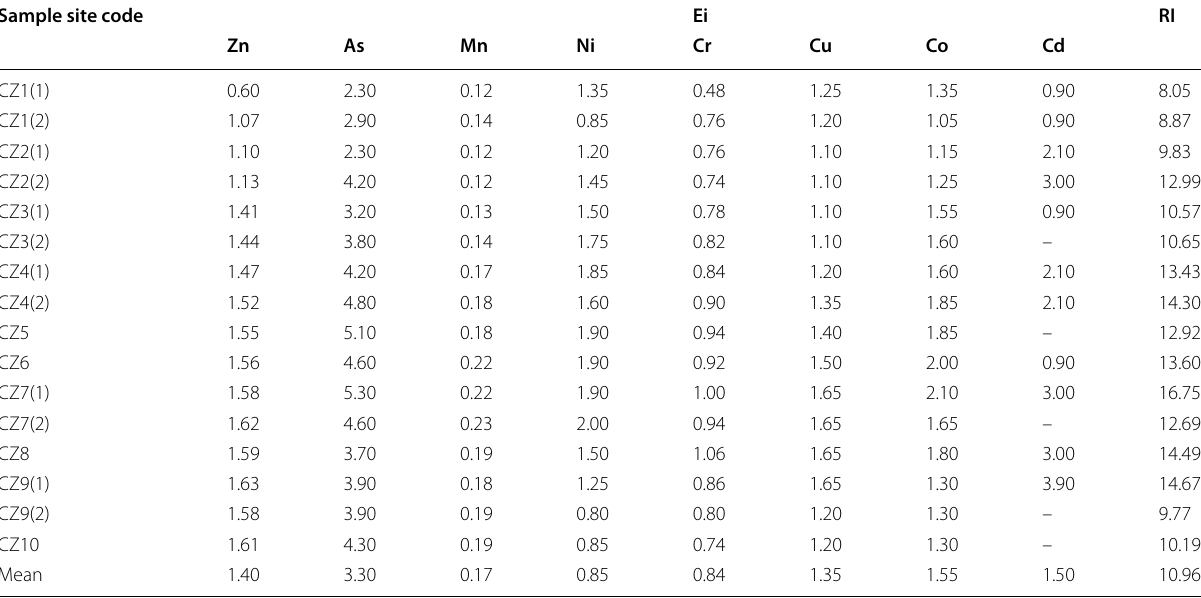
Details of sample site codes are mentioned in the materials and methods section